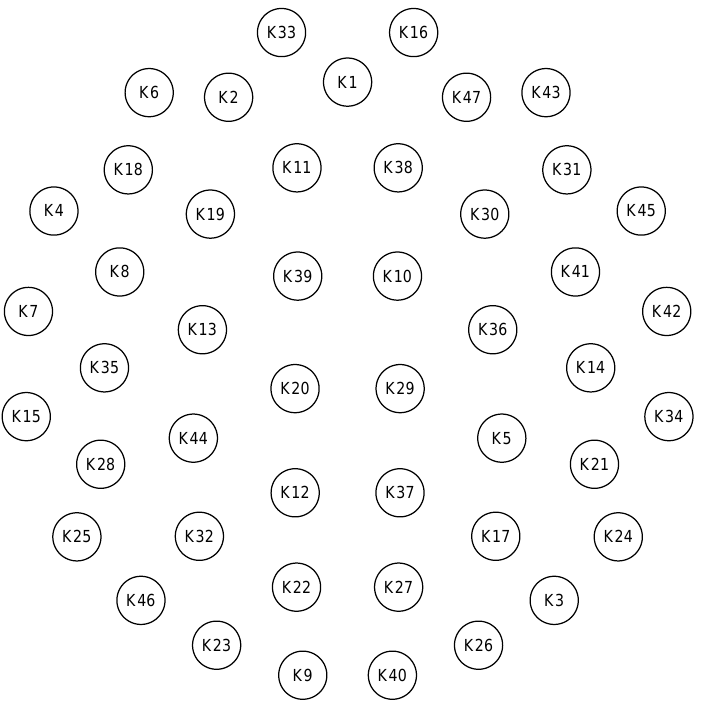
Figure 3. Consonance of the overall influence of concepts when using the operator combination T -norm Minimum and S -norm Maximum and relevancy threshold of 0.85.